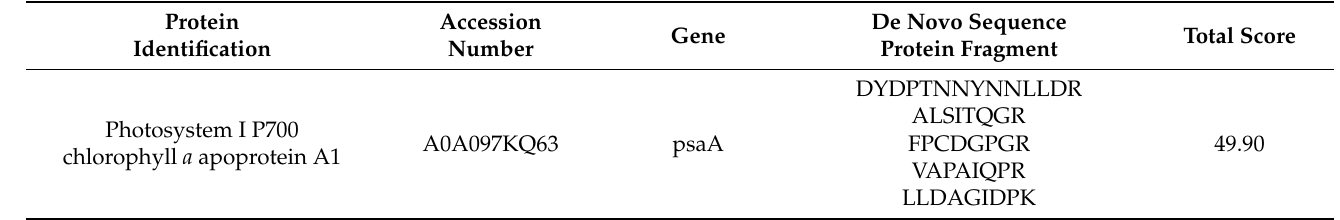
Figure 2. Protein composition of B. braunii PSI-LHCI. Polypeptide composition of B. braunii PSI-LHCI (1.0 mg/mL) identified by LC – MS/MS. Electrophoresis was performed on a 4 – 20% polyacryla- mide gel. The gel was Coomassie blue-stained. Table 2. Polypeptide composition of B. braunii PSI-LHCI complex. Proteins were identified by LC- MS/MS.